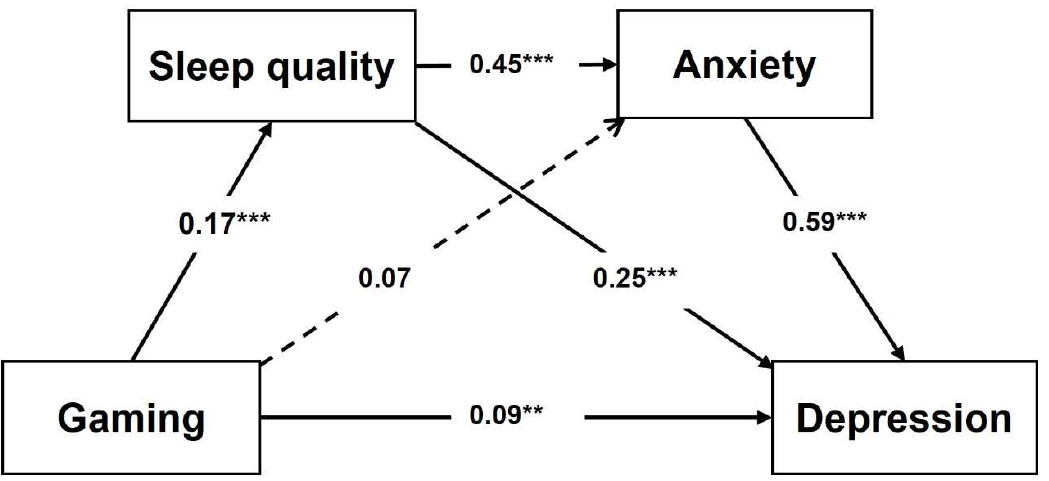
Figure 3. Mediating Model 2 for depression (serial mediation). Note: The numbers on the paths are standardized β coefficients. ** p < 0.01, *** p < 0.001.